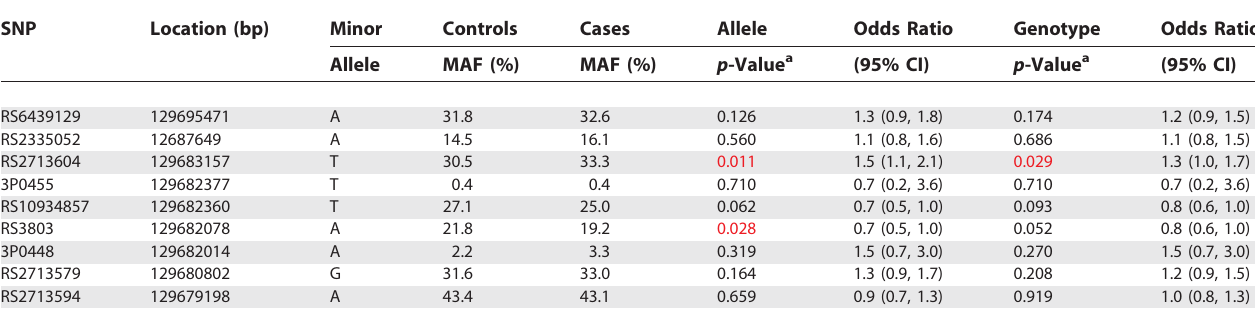
Table 6. Replication of GATA2 SNPs Associated with Early-Onset CAD in the CATHGEN Case-Control Sample Set SNP Location (bp) Minor Controls Cases Allele Odds Ratio Genotype Odds Ratio